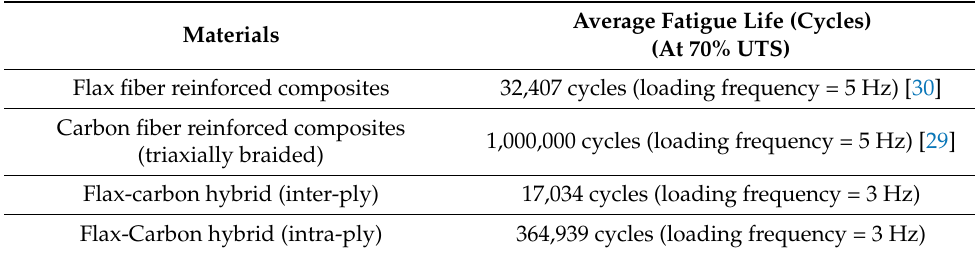
Table 4. Comparison of fatigue life of hybrid flax-carbon fiber reinforced composite (inter-ply and intra-ply) with inbred flax-and carbon fiber reinforced composite.